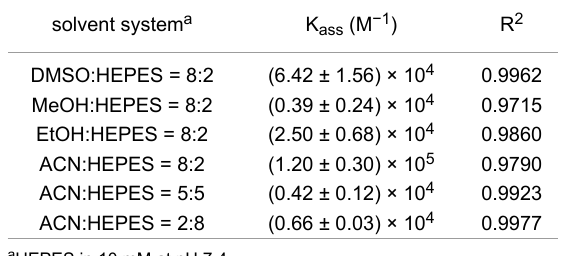
Table 1: The association constants K ass of Cd 2+ – ACAQ (5 µM) and L-cysteine in different solvents. solvent system a